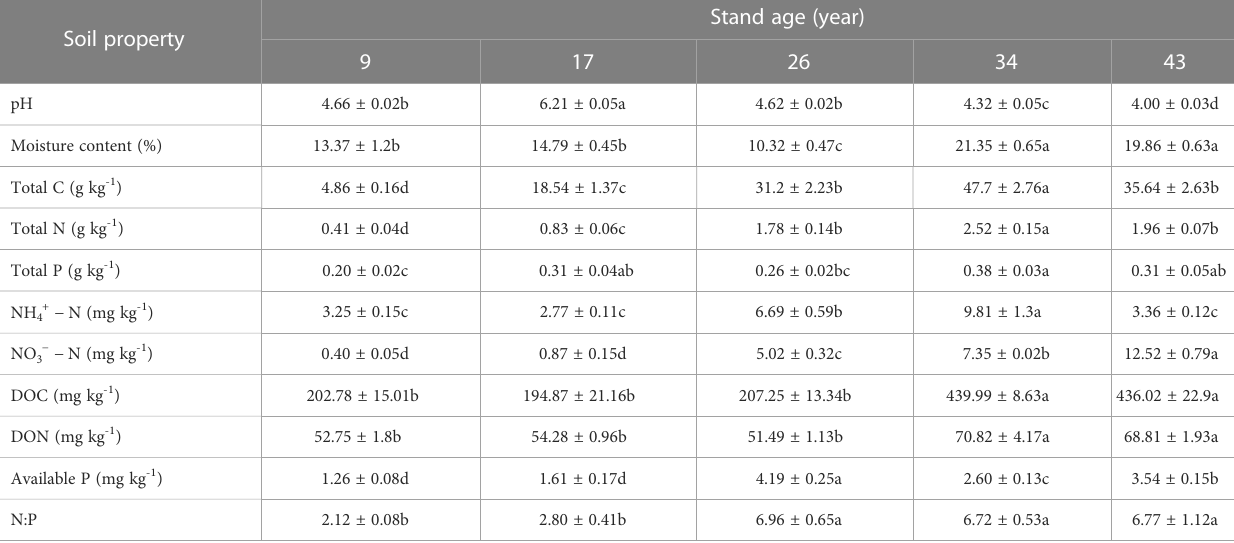
TABLE 2 Soil properties in Pinus massoniana plantations with different stand